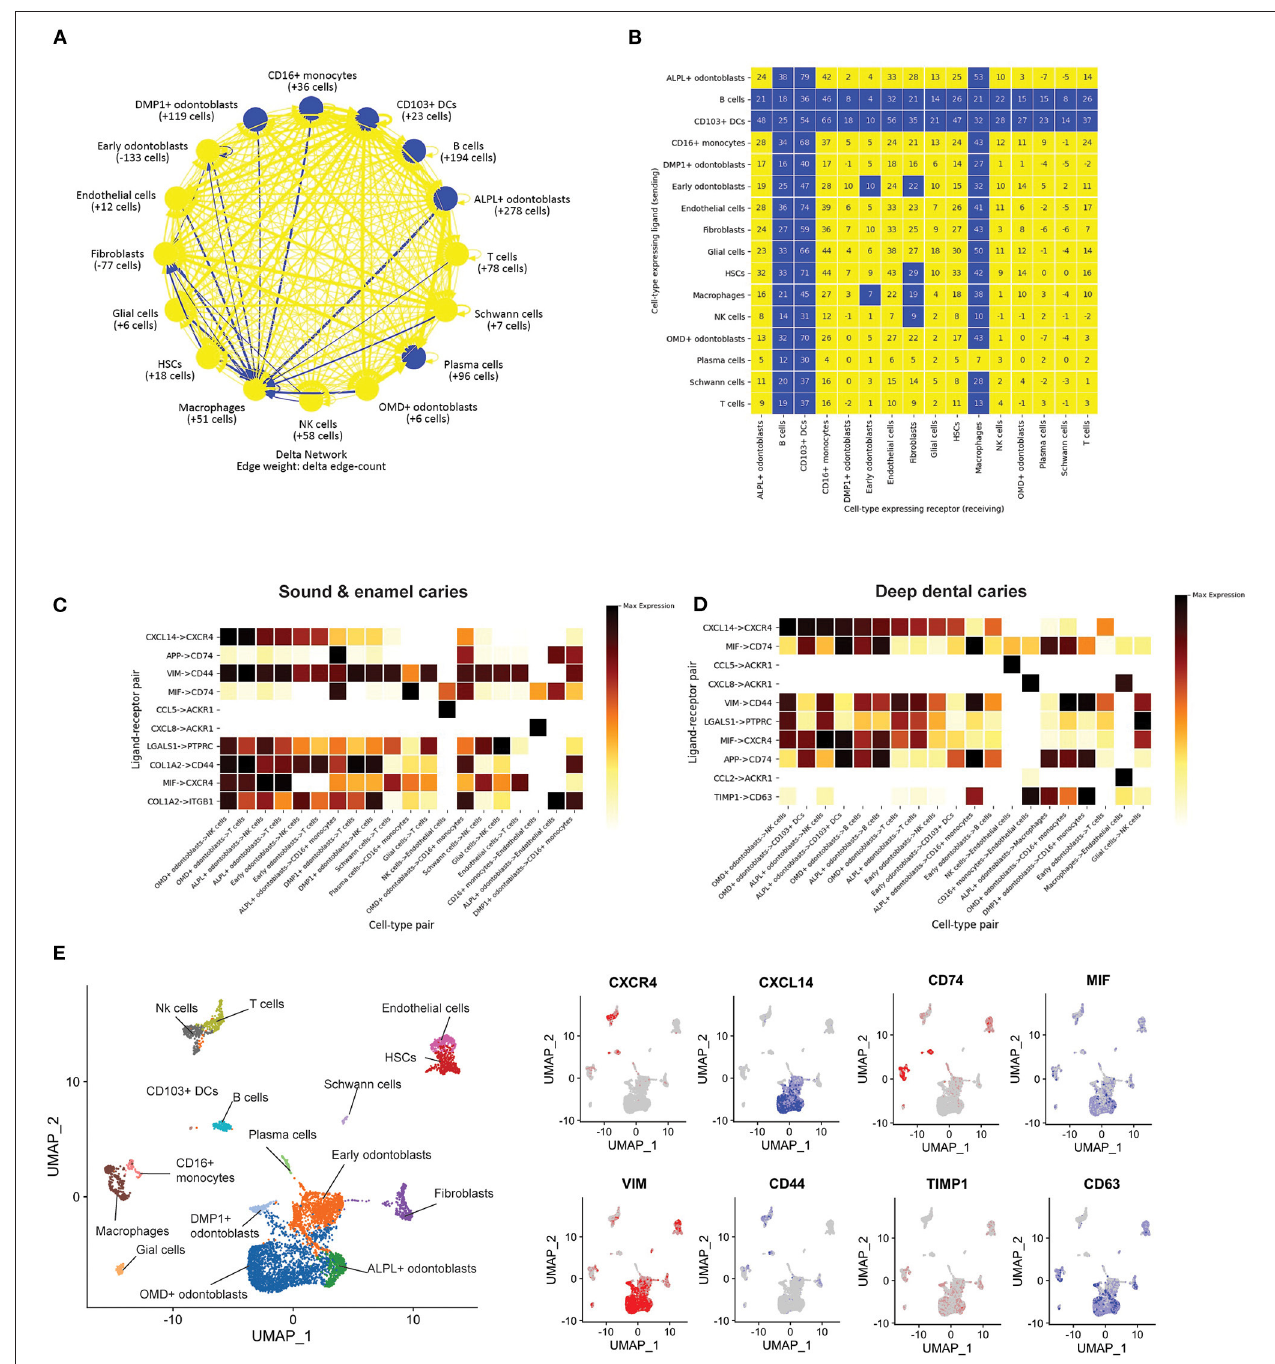
FIGURE 4 | Predicted cell-cell communication in the dental pulp. (A) Interaction networks between cells in different tissues/cell types in our dental pulp samples. Arrows were drawn from ligand expressing cells to receptor expressing cells. Blue lines indicate higher numbers of interactions in the deep dental caries as compared to the sound tooth/enamel caries. (B) The difference in total number of edges between ligands and receptors between each cell type. Blue boxes indicate significantly higher numbers of interactions in dental caries. (C) Ligand-receptor pairs with the highest level of expression in sound tooth combined enamel caries and (D) deep dental caries. Darker shades represent higher levels of expression (E) Expression levels of representative ligands (red) and receptors (blue), projected on UMAP. the dental pulp. Here, we have shown that in the deep dental inflammation (40). Whether HSCs play an important role in caries that HSCs served as a source of IL-6 and CXCL8 the overall inflammatory status of dental pulp, remains to be further expression, pro-inflammatory cytokines reported in pulpal